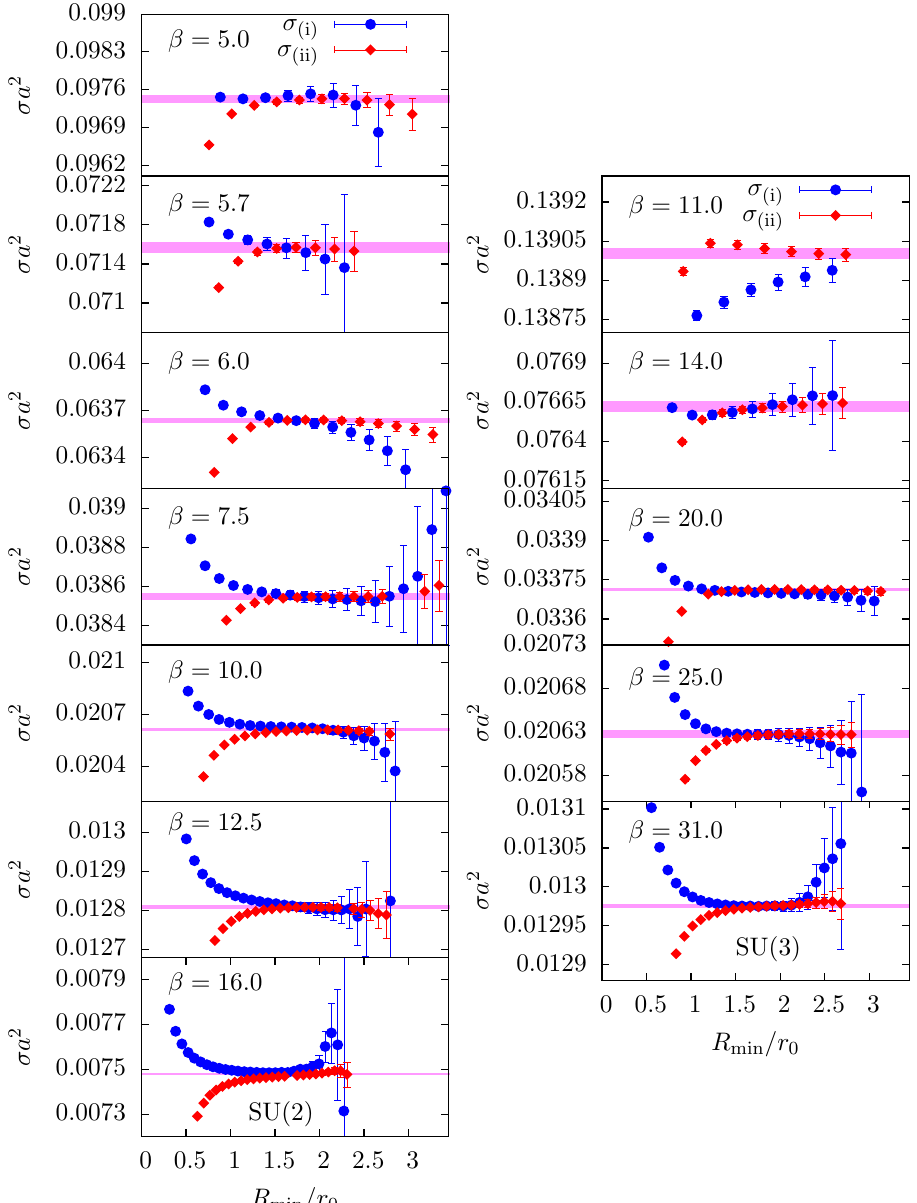
Figure 1 . Results for the string tension in SU(2) (left) and SU(3) (right) gauge theory extracted from method (i), (cid:27) (i) , and (ii), (cid:27) (ii) , as explained in the text, versus the minimal value of R included in the (cid:12)t, R min in units of r 0 . The red bands are the values for (cid:27) ( ii ) which we will use for the further